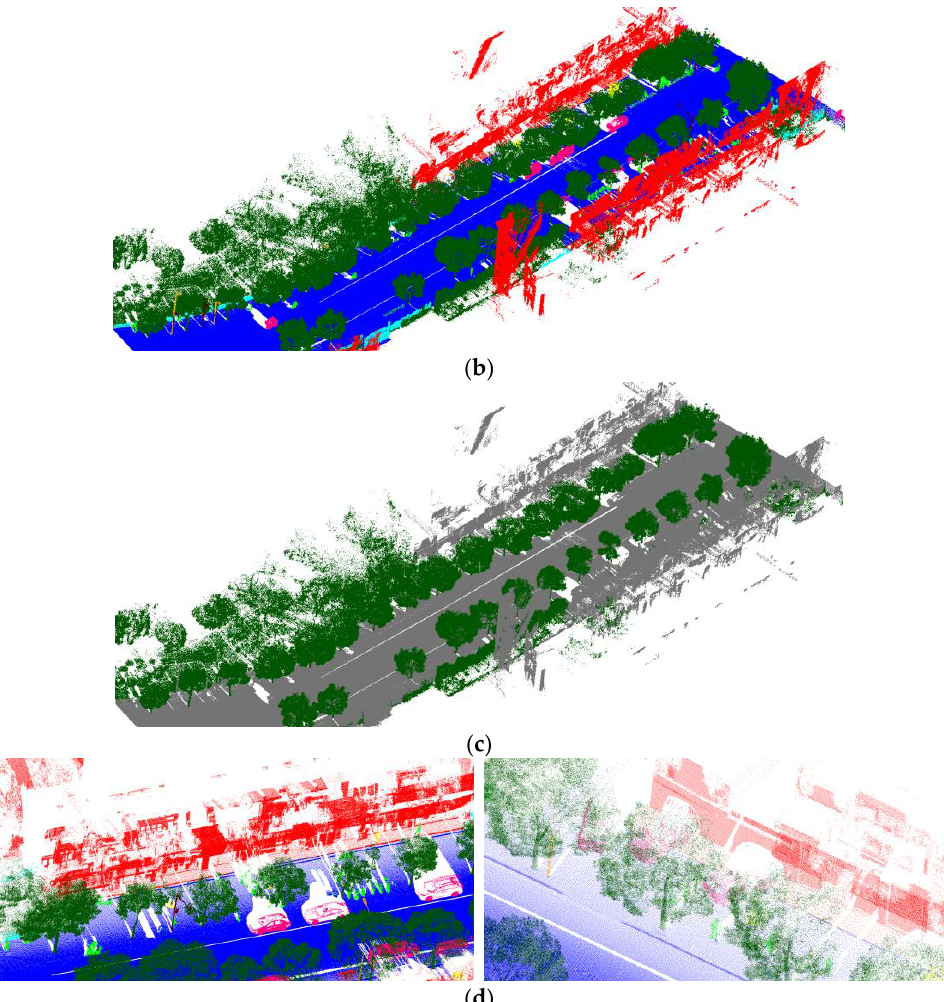
Figure 7. Example of urban MLS point cloud semantic segmentation on Dataset II. ( a ) Raw urban MLS point cloud, ( b ) point cloud semantic segmentation result, dotted in different colors according to the labels, ( c ) tree point extraction result, where green and gray points represent points from trees and non-tree objects, respectively, ( d ) two close-up semantic segmentation results at some selected regions.